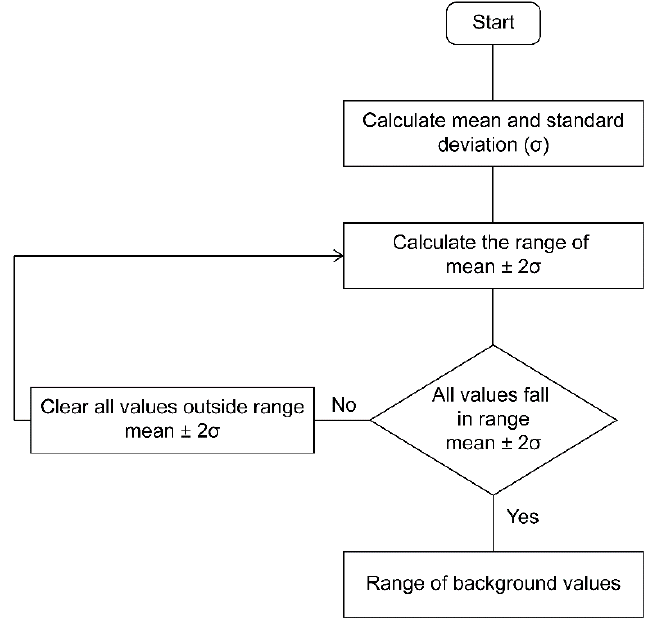
Figure 2. Flow chart for calculating geochemical background values.